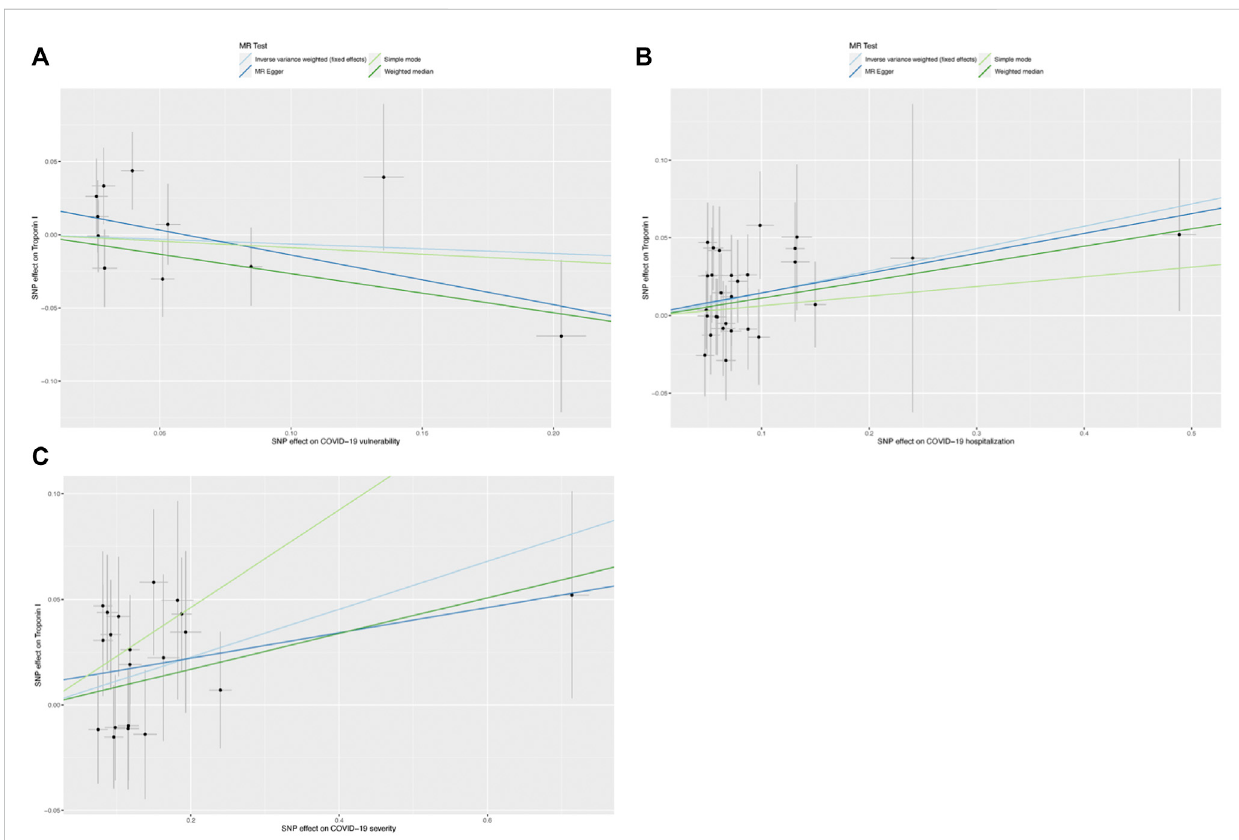
FIGURE 5 Scattergraphsforsingle-nucleotidepolymorphisms(SNPs)concerningCOVID-19andcardiacinjury. (A) ScattergraphforSNPsconcerningCOVID- 19 vulnearability and cardiac injury risk; (B) Scatter graph for SNPs concerning COVID-19 severity (hospitalization) and cardiac injury risk, and (C) Scatter plot of SNPs concerning the severity of COVID-19 (severe respiratory symptoms) and risk of cardiac injury.